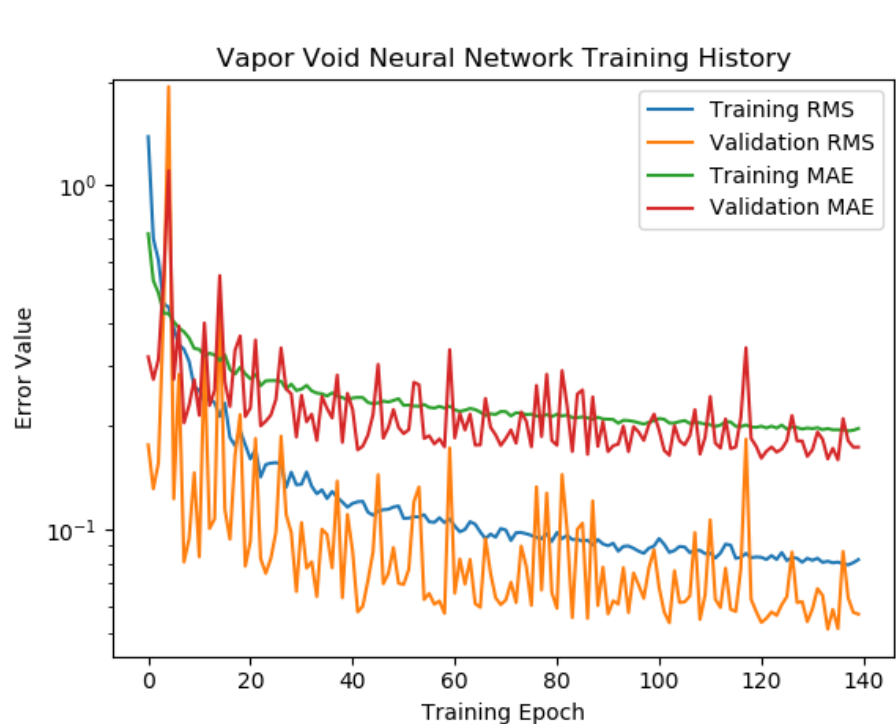
Figure 2. Training history of the neural network for predicting vapor void sum in